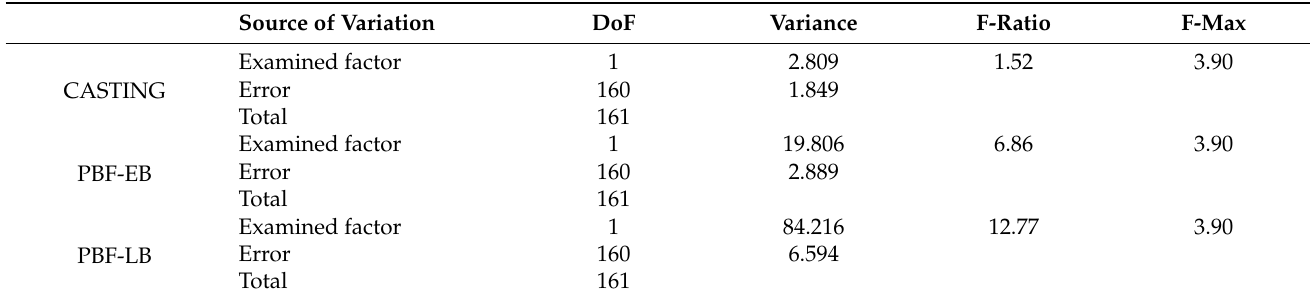
Table 5. ANOVA results of surface roughness in the two directions.